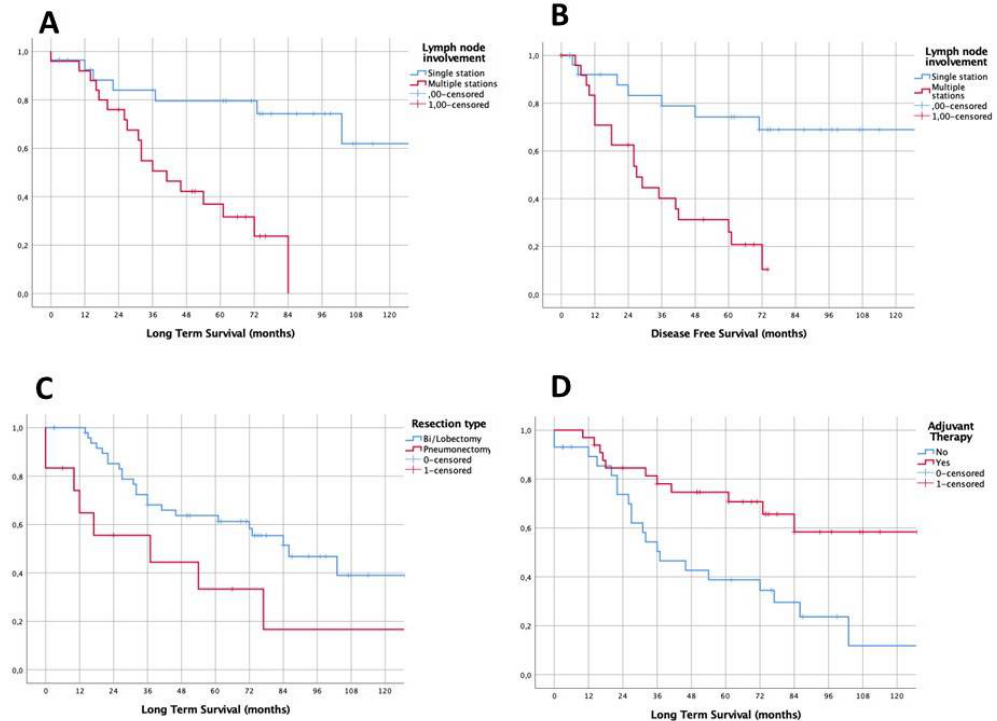
Figure 3. Survival functions according with nodal mediastinal involvement at diagnosis ( A , B ), surgical resection ( C ) and adjuvant treatment ( D ).